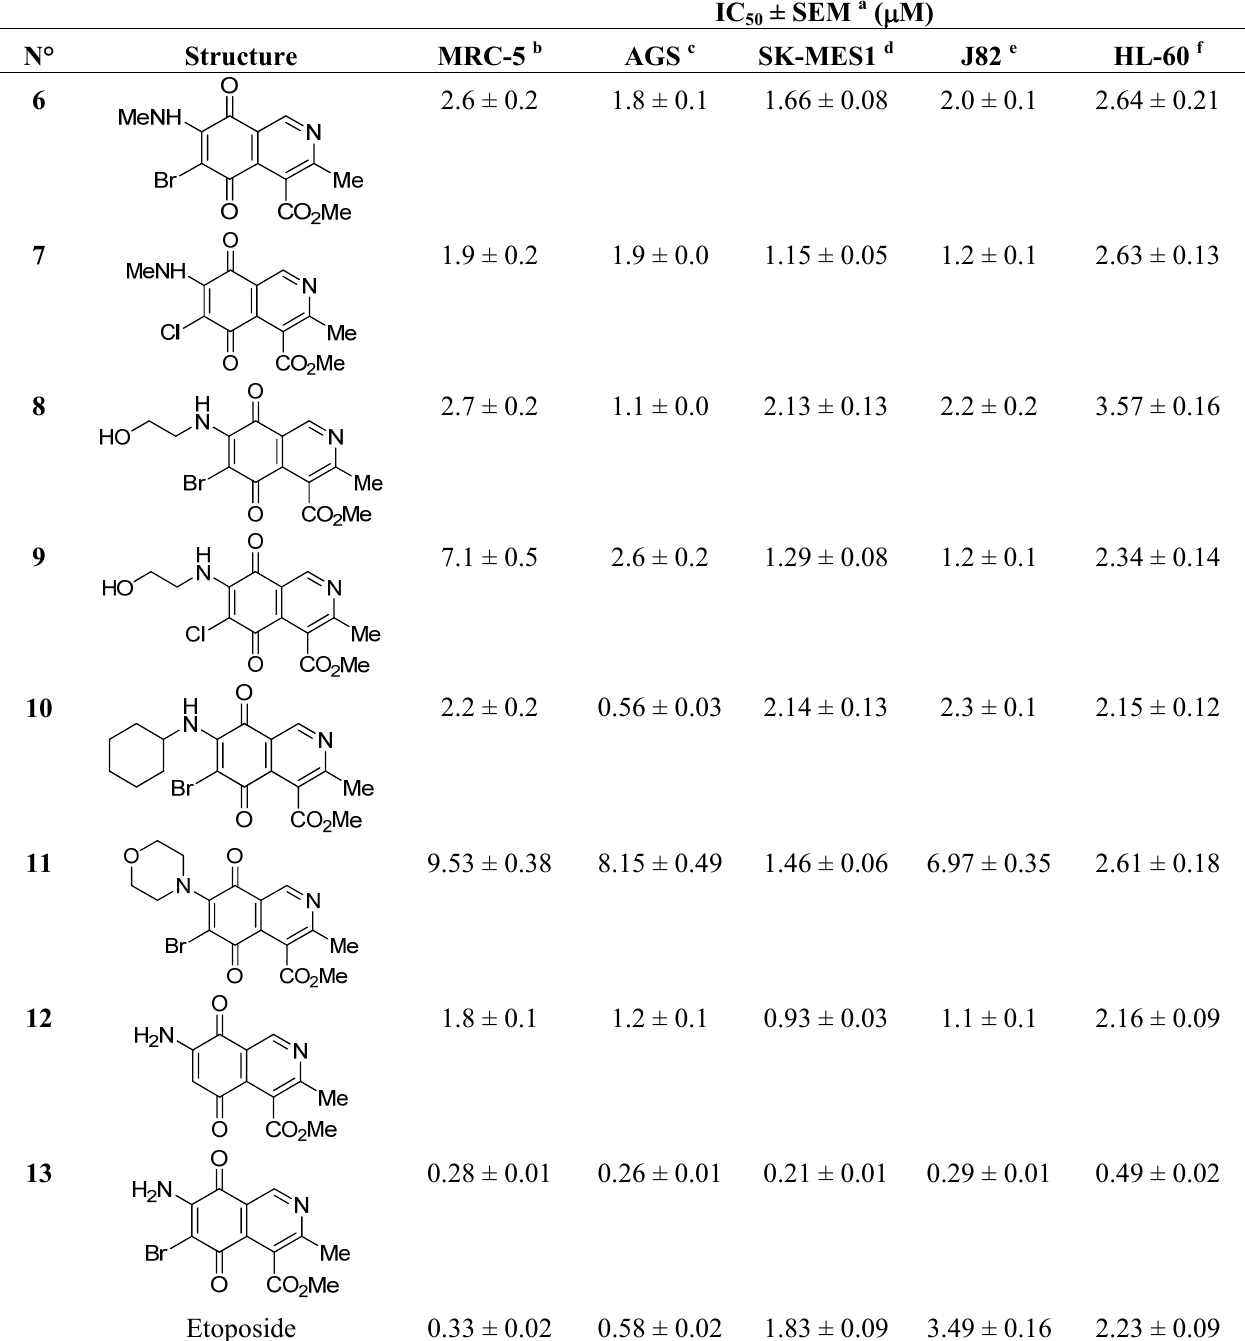
a Data represent mean average values for six independent determinations; b Normal human lung fibroblasts cells; c Human gastric adenocarcinoma cell line; d Human lung cancer cell line; e Human bladder carcinoma cell line; f Leukemia cell